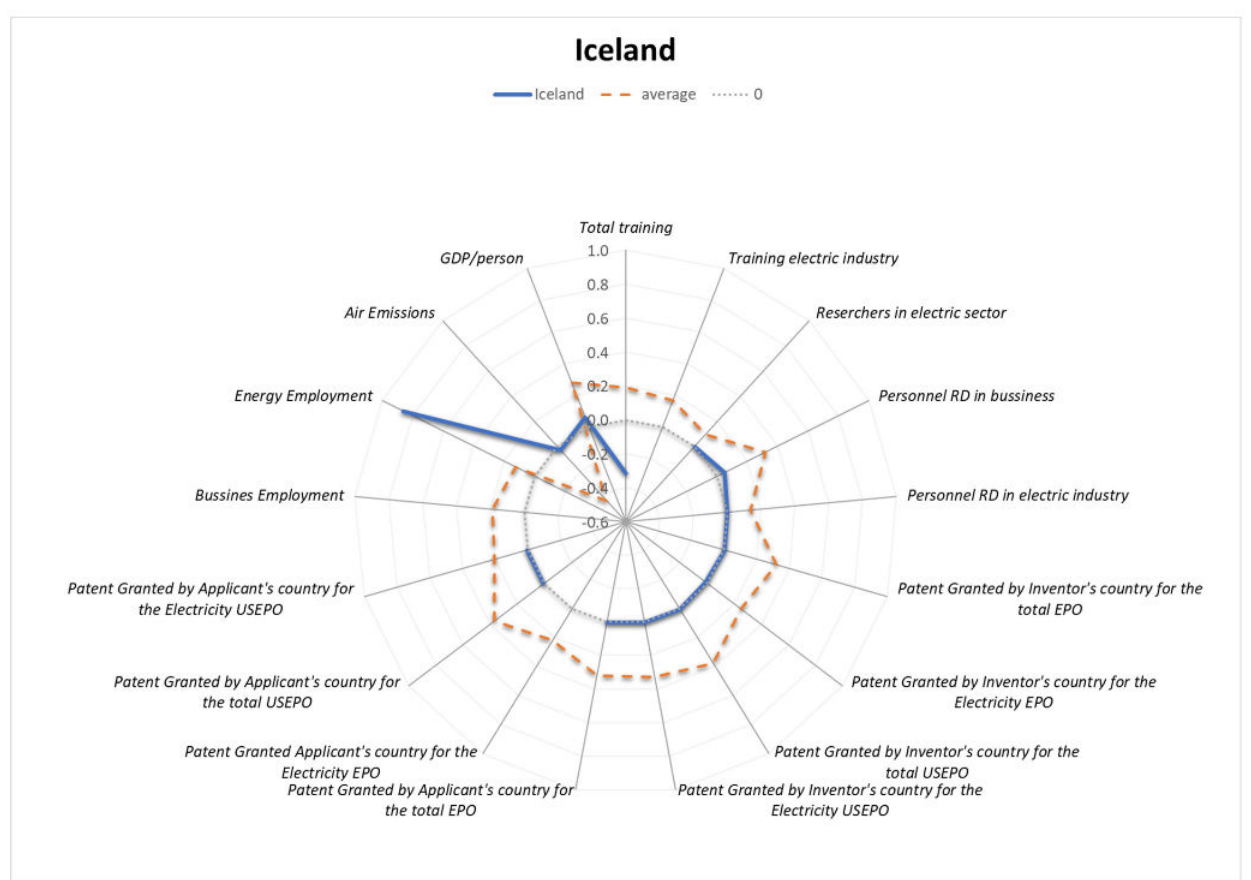
Figure 21. Synergy and trade-off occurrence—IS. Source: Authors’